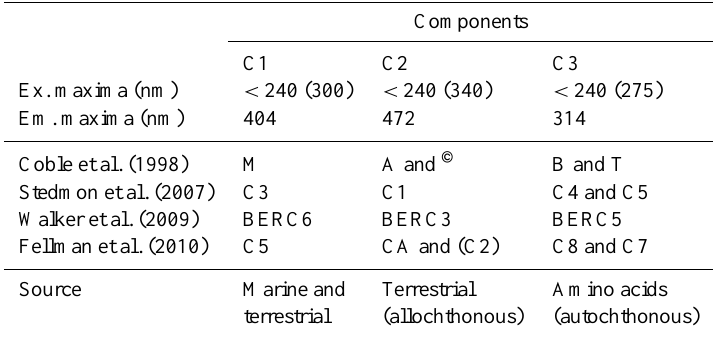
Table 3. Spectral characteristics of the three components identified by PARAFAC analysis compared to previously identified components, including Arctic and sub-Arctic studies (Stedmon et al., 2007; Walker et al., 2009; Fellman et al., 2010). Position of Ex/Em maxima of C1, C2 and C3 are deduced from their corresponding spectra reported in Fig.